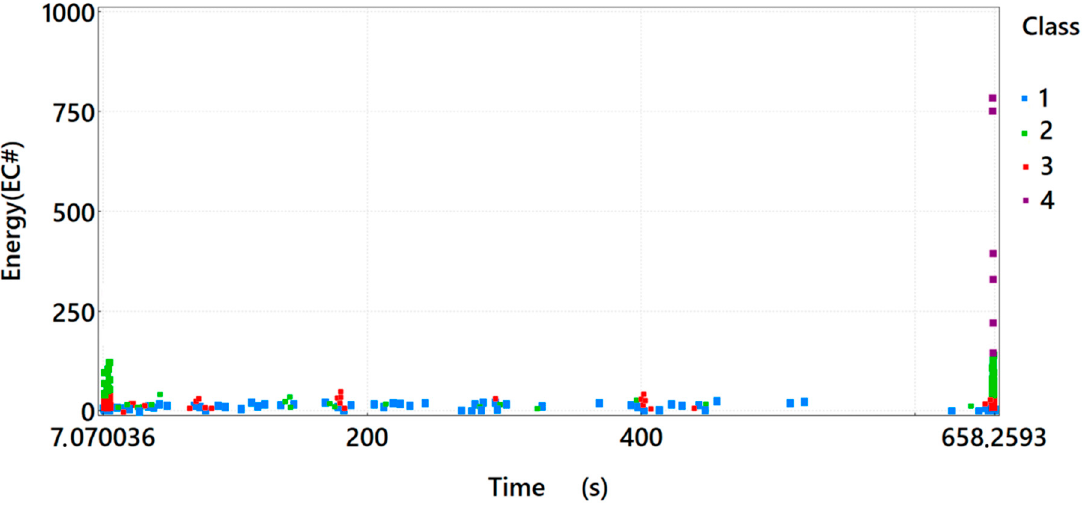
Figure 3. Graph of energy in time, taking into account the division of the recorded signals of acoustic emission into classes for sample A 1 .